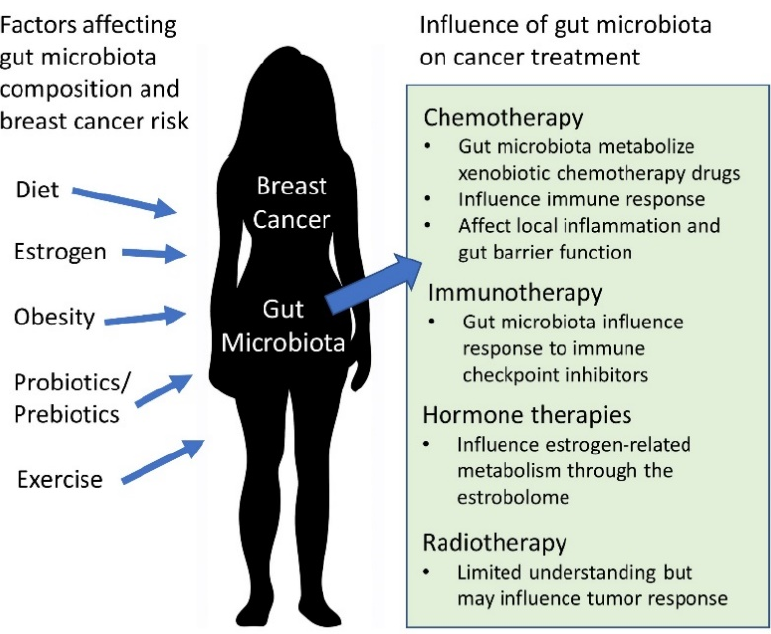
Figure 1. Potential relationship between gut microbiota and breast cancer.